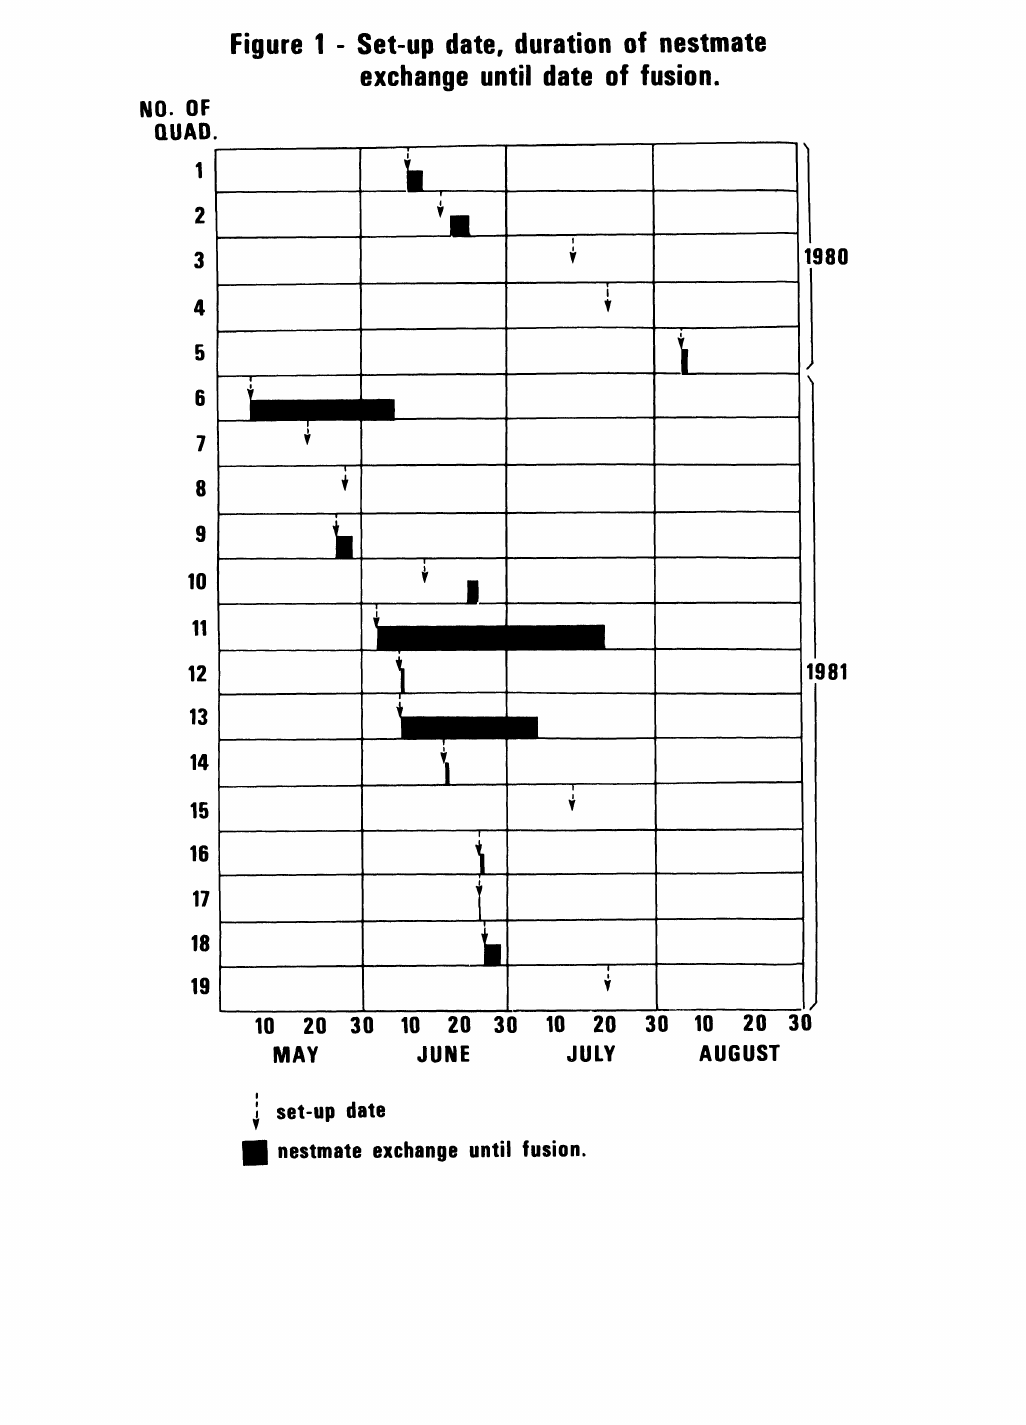
Figure 1 Set-up date, duration of nestmate exchange until date of